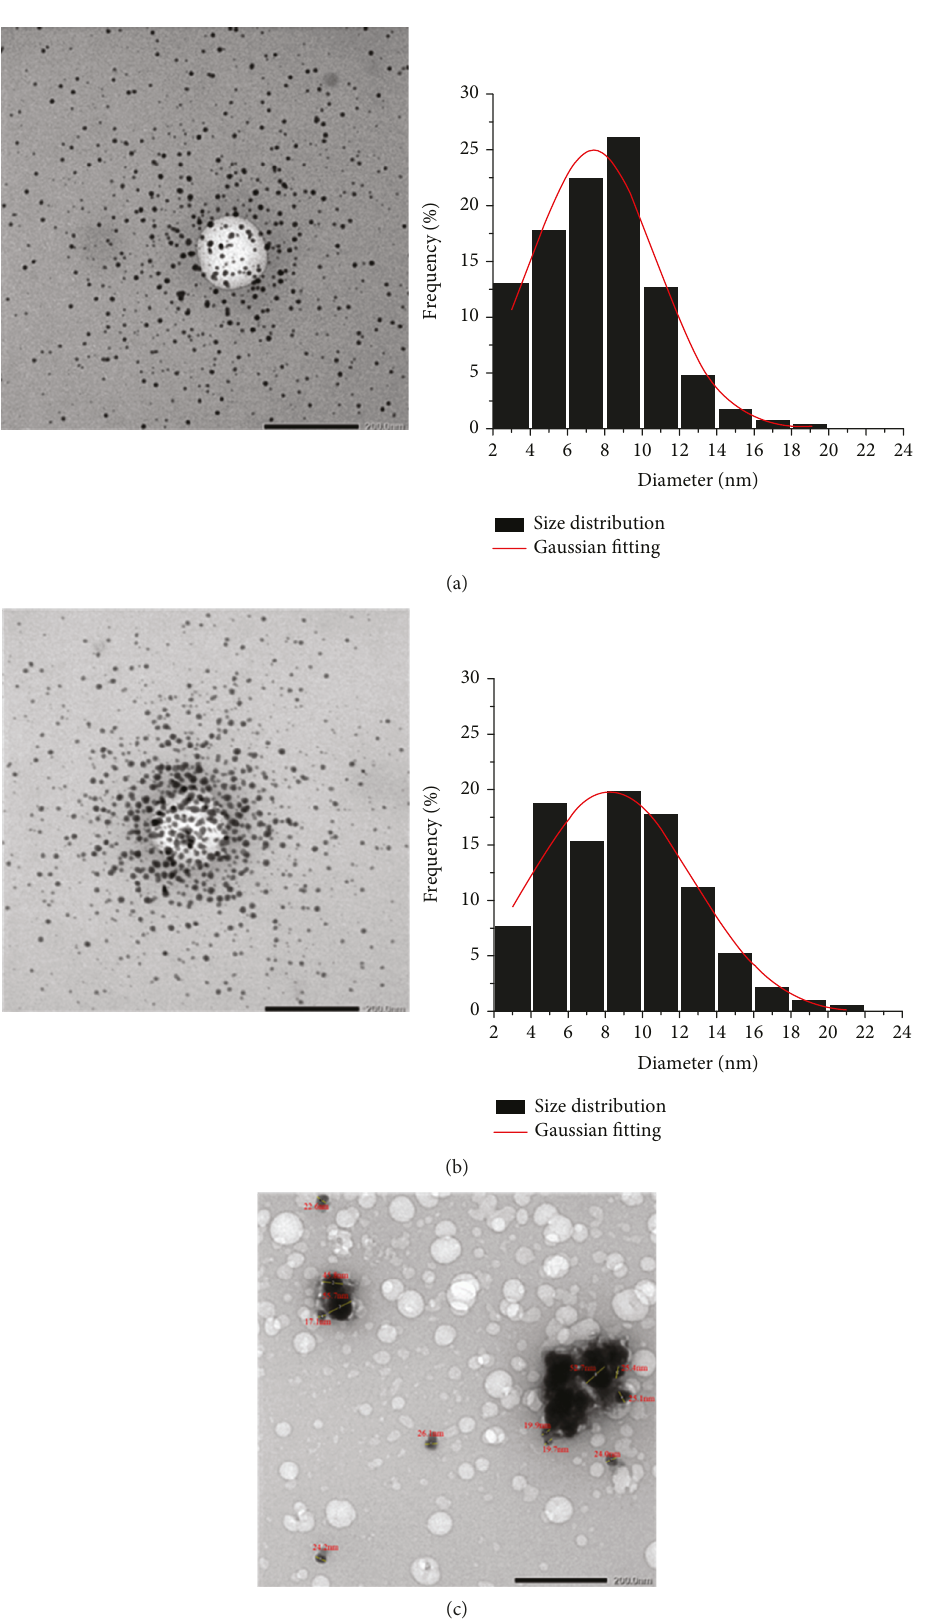
Figure 2: TEM images and particle size histograms of PCA15 (a), PCA30 (b), and PCA60 (c) fi tted by log-normal distribution function; scale bar: